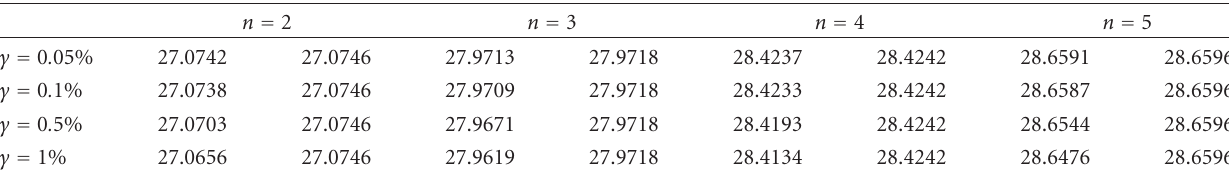
Table 2: Modal frequencies ω n , l in rad/s, relevant to the imperfect rotor and evaluated according to the EB model. The imperfection is introduced by increasing the mass of the fourth blade of the perfect rotor described in Section 4.1 by γ = 0 . 05%, 0 . 1%, 0 . 5%, and 1%, with respect to its nominal value. Modal frequencies relevant to modal numbers n = 2 · · · 5 and l = 1.